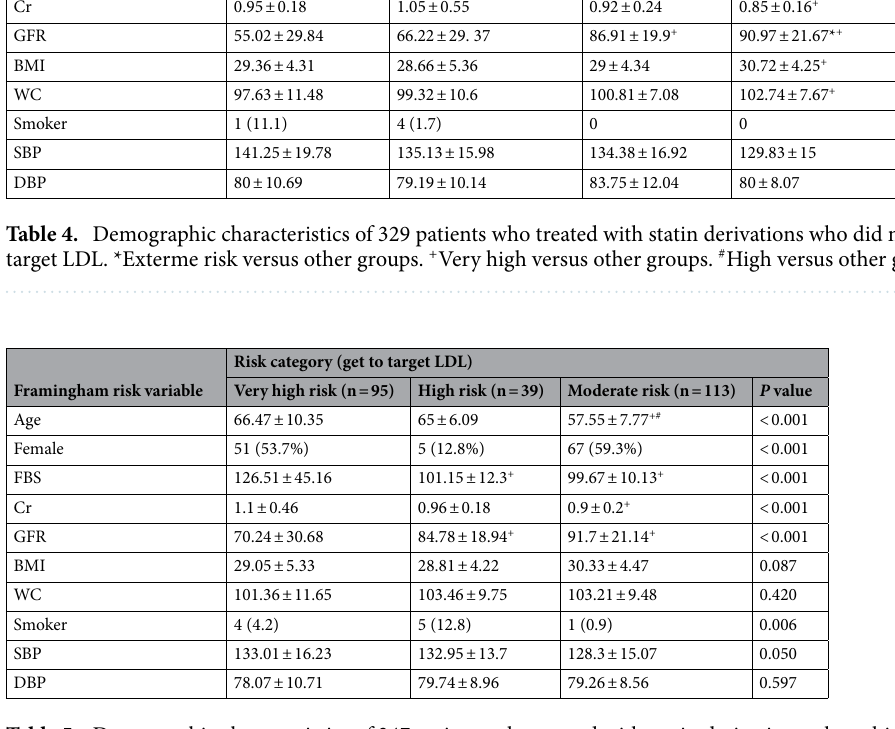
Table 5. Demographic characteristics of 247 patients who treated with statin derivations who achieved to target LDL. *Exterme risk versus other groups. + Very high versus other groups. # High versus other groups.